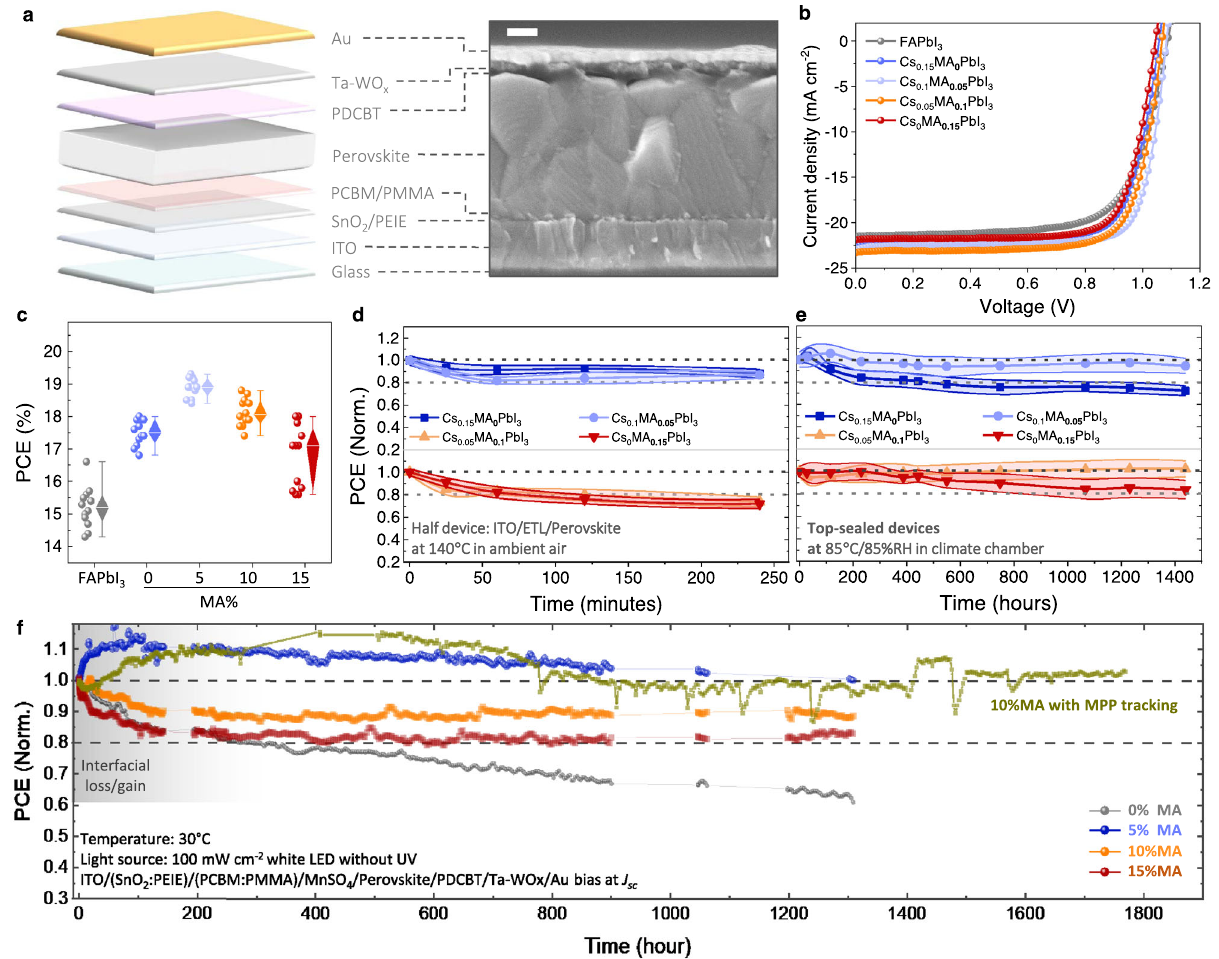
Fig. 4 Device characterizations of Cs x MA 0.15 – x FA 0.85 PbI 3 perovskite solar cells. a Schematic of the solar cell architecture and the corresponding cross- sectional SEM image of the device. b Current density – voltage ( J – V ) curves for FAPbI 3 and Cs x MA 0.15 – x FA 0.85 PbI 3 ( x = 0, 5, 10, and 15%) perovskite solar cells with a scanning rate of 20 mV s − 1 from − 0.1 to 1.2 V. c Statistical PCE of 12 devices for each FAPbI 3 and Cs x MA 0.15 – x FA 0.85 PbI 3 ( x = 0, 5, 10, and 15%) perovskite solar cell. d Statistic PCE evolution under 140 °C/35%RH conditions in ambient air. The device was aged before depositing the hole transporting layer and Au. e Statistic PCE evolution under 85 °C/85%RH conditions in a climate chamber. f Long-term stability for Cs x MA 0.15 – x FA 0.85 PbI 3 ( x = 0, 5, 10, and 15%) perovskite solar cells tested under 100 mWcm − 2 white LED illumination. The ef fi ciency was recorded with a scanning rate of 20 mV s − 1 from 1.2 to − 0.1 V as the reverse scan. The MPP tracking for 10% MA is based on the stabilized ef fi ciency biased at the maximum power point in reverse-scan mode. The device temperature is controlled at ~30 °C by a cooling